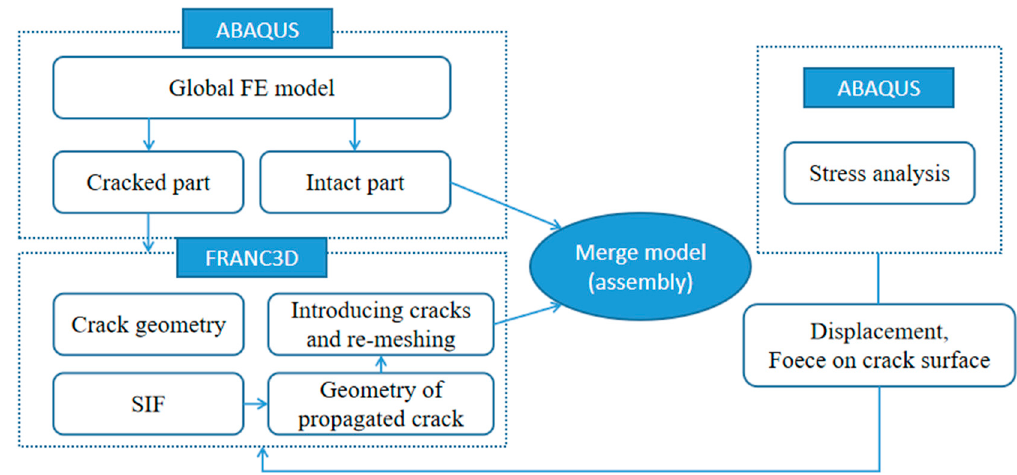
Figure 11. Joint simulation of ABAQUS and Franc3D.